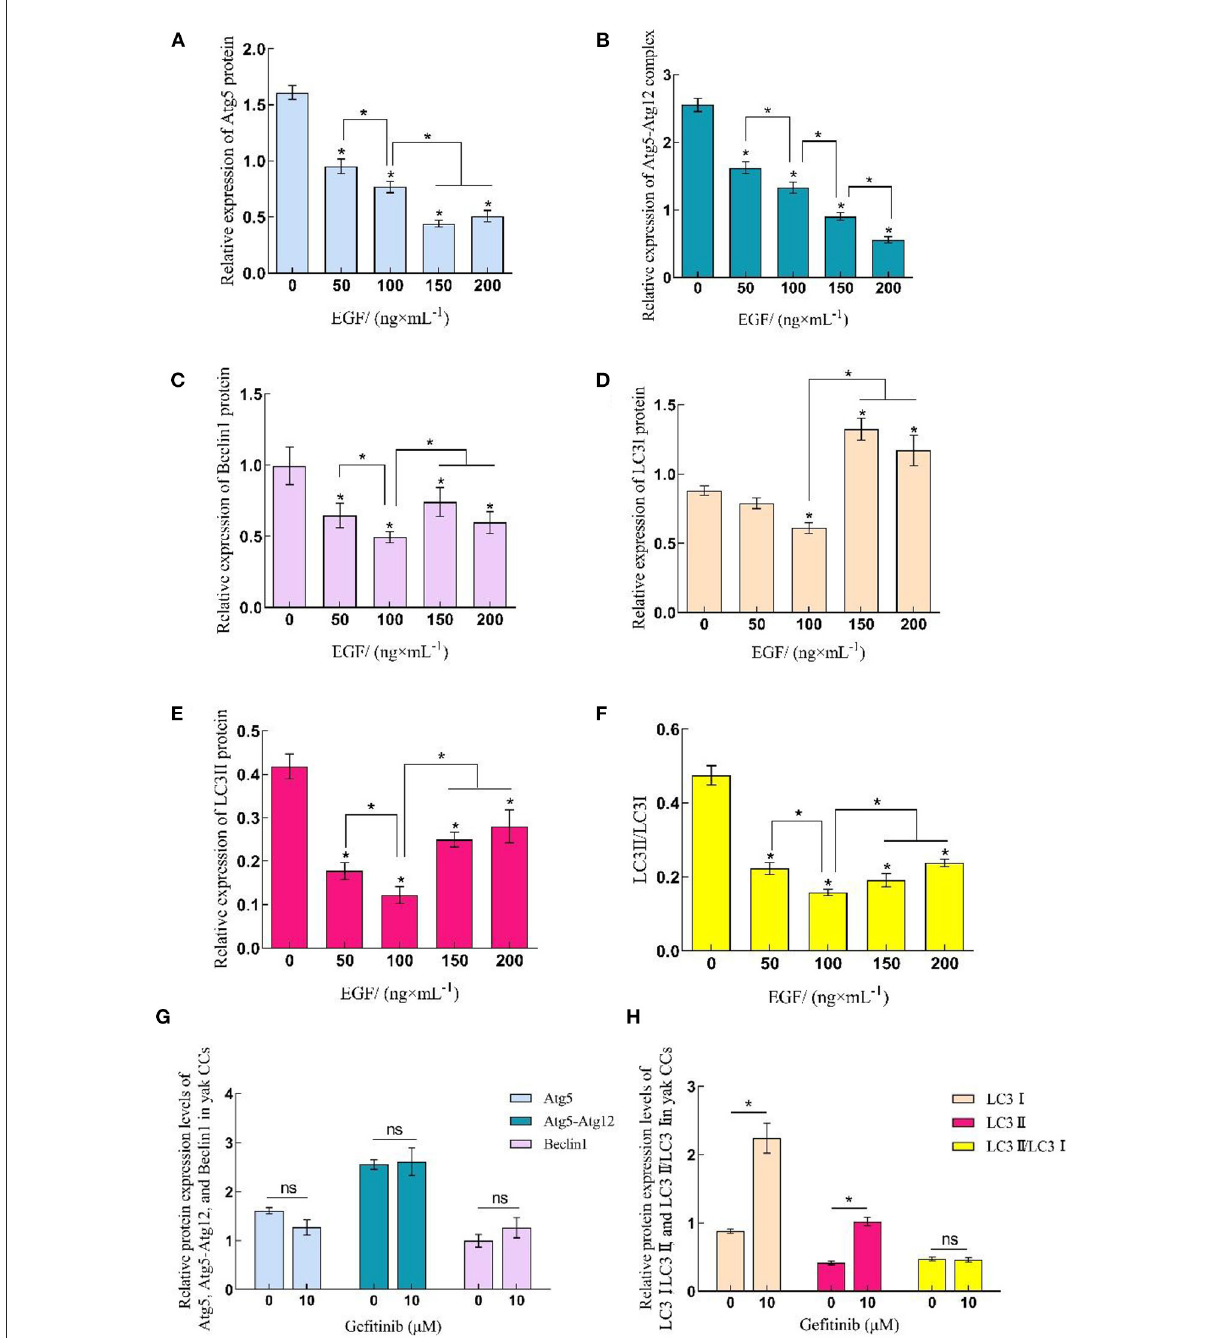
FIGURE4 Relative expression levels of Atg5, Beclin1, and LC3 protein in yak CCs treated with different concentrations of EGF and the optimal concentration of gefitinib (EGFR inhibitor). (A–F) Relative protein expression levels of Atg5, Atg5-Atg12, Beclin1, LC3I, LC3II, and LC3II/LC3I in yak CCs (EGF group). (G, H) Relative protein expression levels of Atg5, Atg5-Atg12, Beclin1, LC3I, LC3II, and LC3II/LC3I in yak CCs (Gefitinib group). *on the bars indicates values that differ significantly (* P < 0.05).